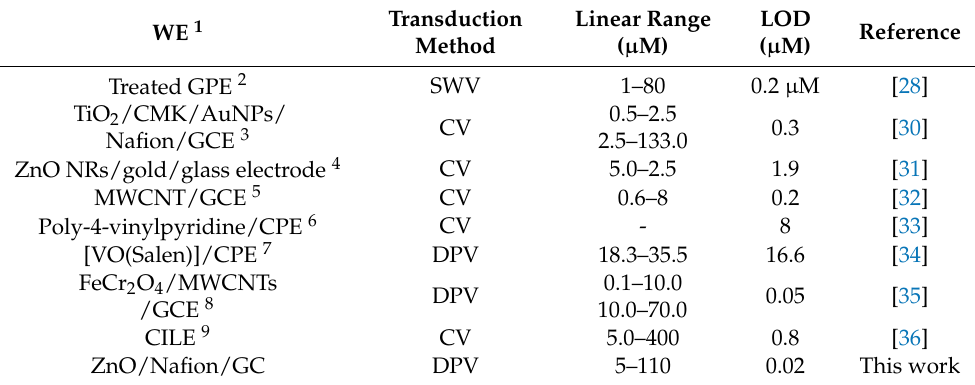
Table 2. Analytical characteristics evaluated for amoxicillin electrochemical